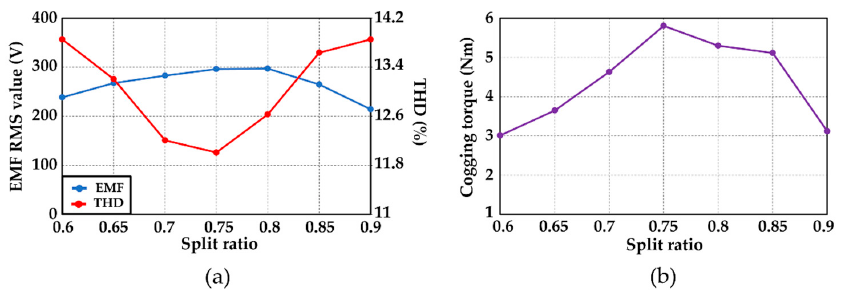
Figure 5. Influence of the split ratio on the ( a ) EMF profile and ( b ) cogging torque of the 12-stator/19-rotor V-shaped FSPM generators.